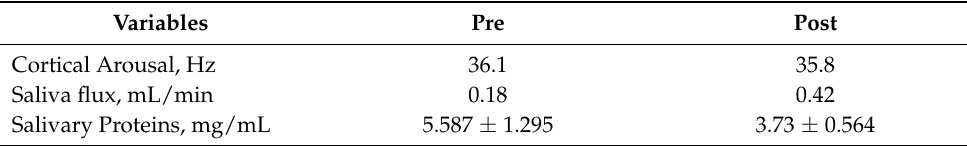
Table 4. Cortical arousal and saliva values before and after the intervention. Variables Pre Post Cortical Arousal, Hz